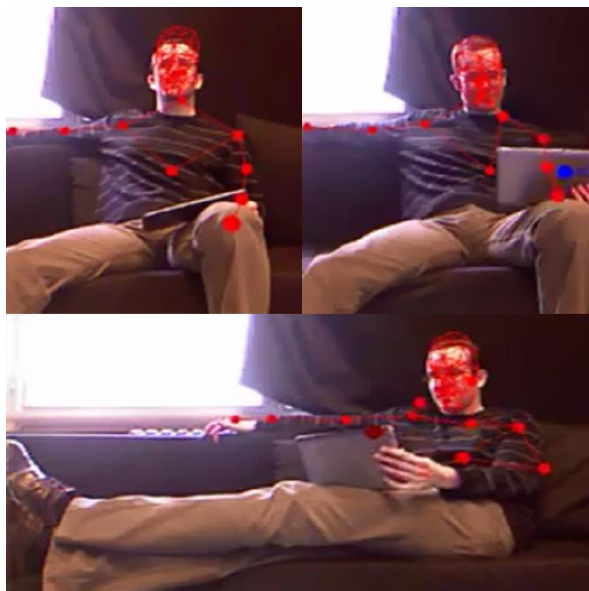
Figure 27. Preliminary test in relaxed positions on a sofa with a tablet as second screen